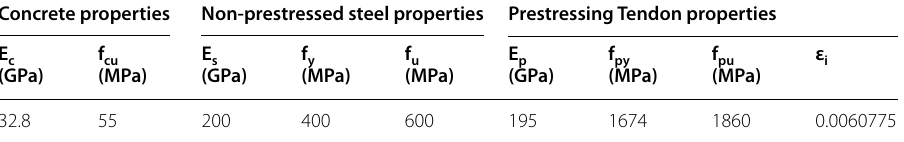
Table 1 Material properties of the concrete, the reinforcing steel, and prestressing tendon Concrete